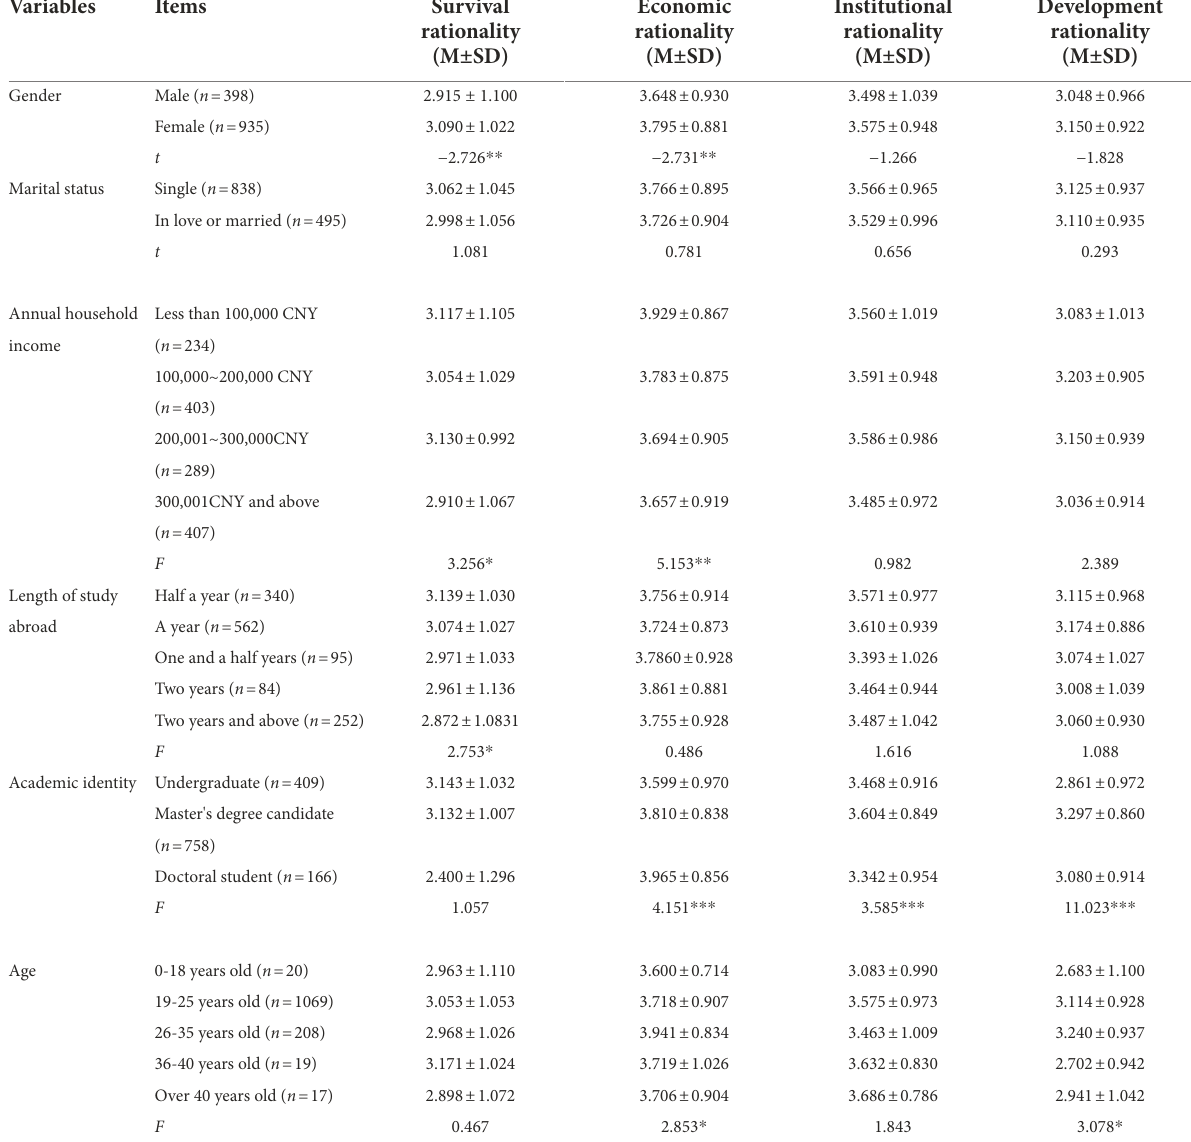
TABLE 5 Descriptive statistics and mean differences.